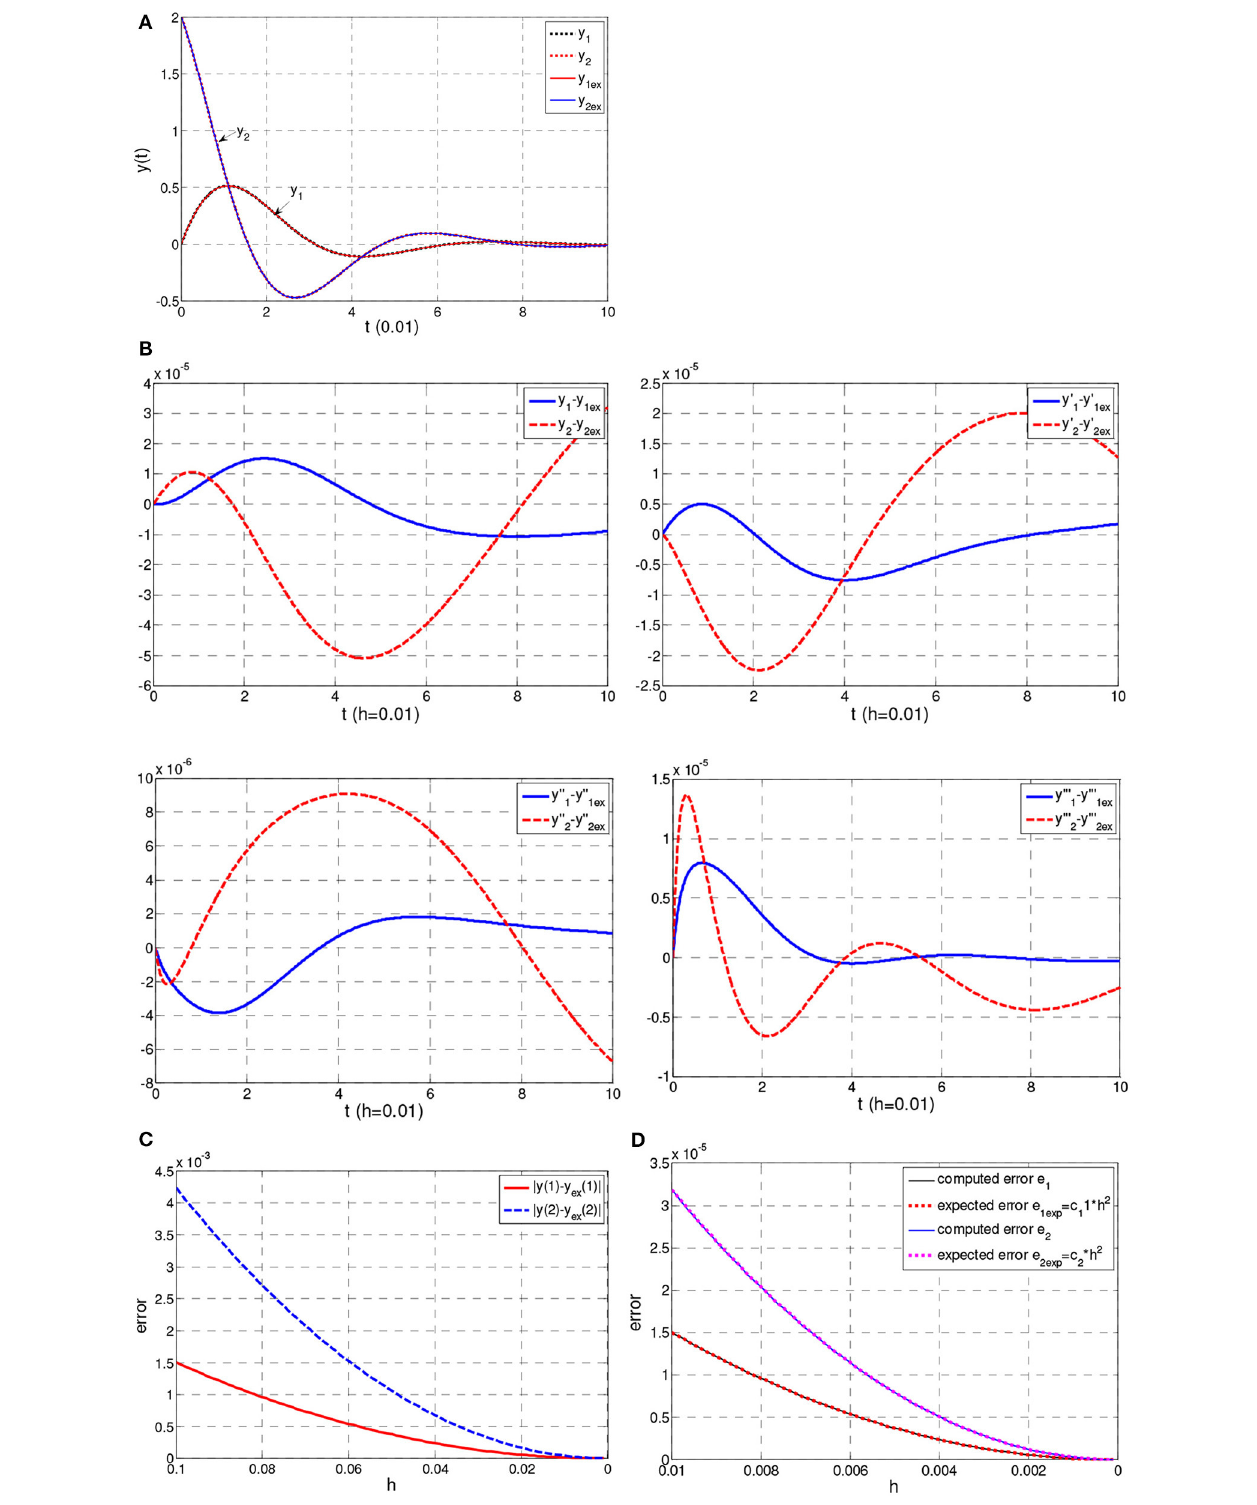
T in Example 3. (B) Error in Example 3. (C) Error max y 1 y 2 } = { e k ( h ); c k e k (1) / h (1) 2 ( k 1,2) in Example 3. = = =